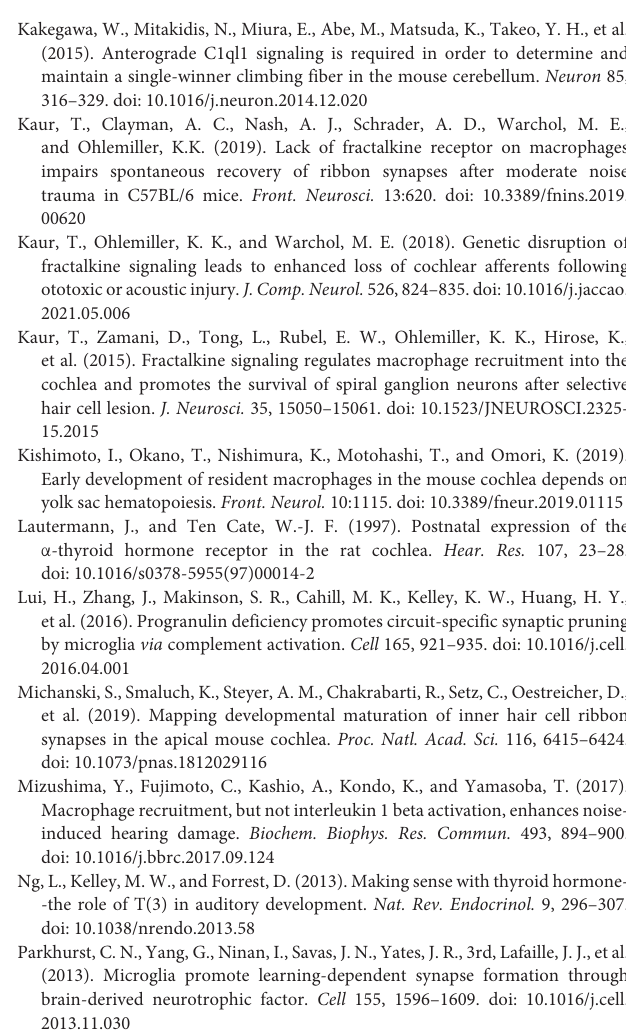
SUPPLEMENTARY FIGURE 1 | Persistent partial elimination of macrophages did not affect ribbon synapses pruning and auditory function. (A) A subset of cochlear macrophages was labeled by crossing LysM-Cre with mTmG mice. mGFP (green), Iba1 (red). (B) Representative confocal images of P12 LysM-Cre control and LysM-Cre:Rosa26-DTA cochlear ribbon synapses at 16 kHz. (C,D) Quantitative analyses of IHC synaptic ribbons (C) and putative ribbon